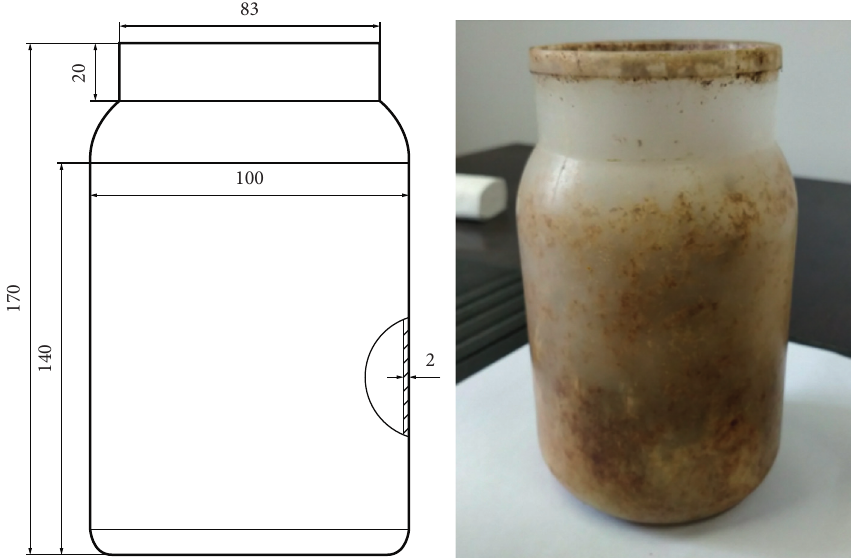
Figure 1: Medium bacteria bottle